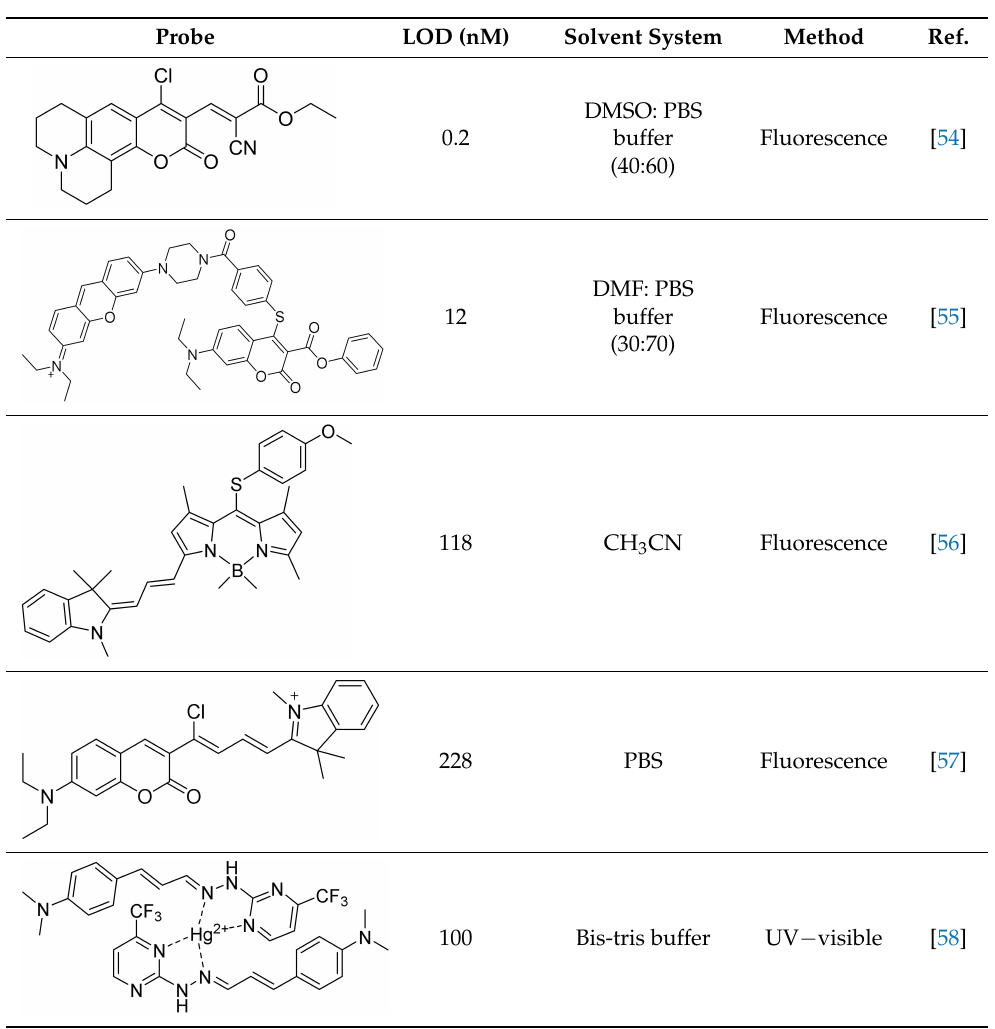
Table 2. Comparison of sensing behavior of present work with the reports in the